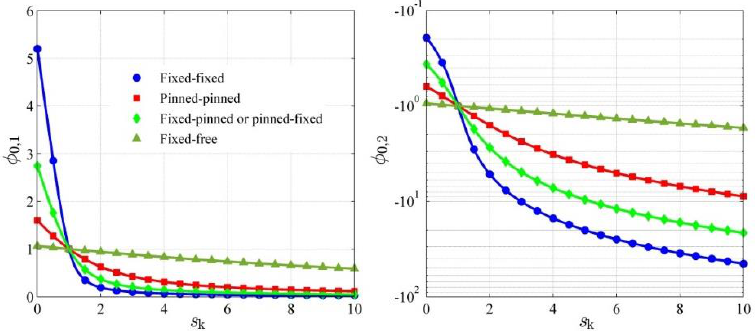
Figure 10. Mode amplitude ratios in two sub-modes corresponding to the 1st basic mode versus beam stiffness ratio for different boundary conditions when 𝑠 e = 100 and 𝑠 m = 1 .